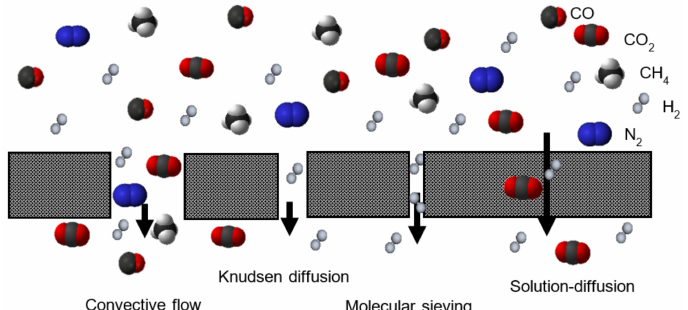
Figure 7. Mechanisms for gas permeation through porous and dense membranes (adapted from Baker (2004)